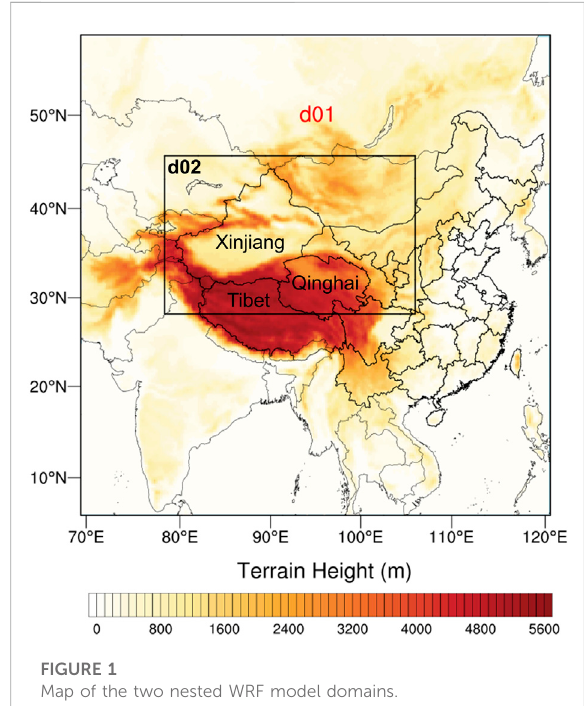
FIGURE 1 Map of the two nested WRF model